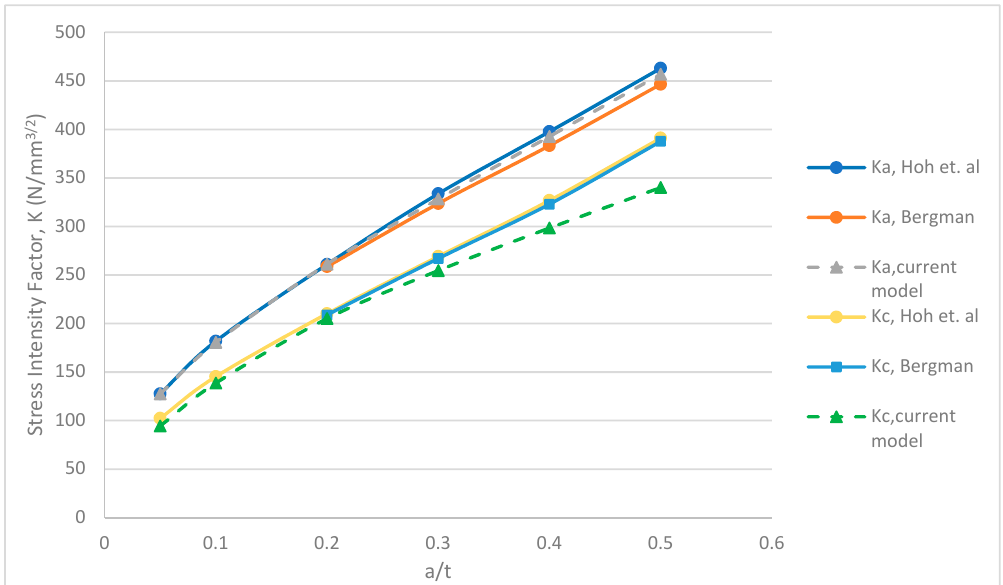
Figure 14. Comparison of SIFs at the deepest point ( K a ) and surface point ( K c ) for semi-elliptical surface cracks in plain pipe under tension for a/c = 0.5.